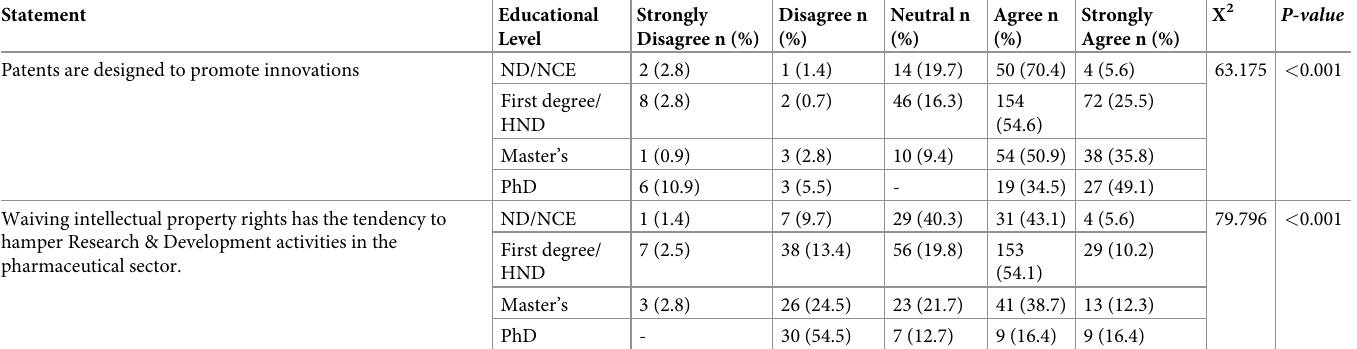
Table 2. Cross tabulation of level of education with intellectual